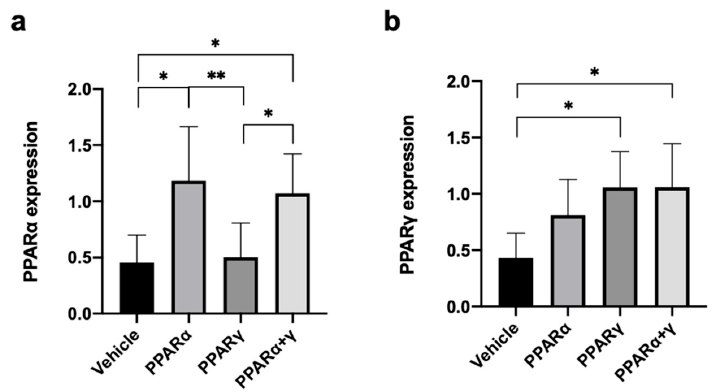
Figure 3. Expression of PPAR α and PPAR γ mRNA. At 6 h, real-time RT-PCR showed upregulation of mRNA expression levels of PPAR α in the alkali-burned cornea after PPAR α and PPAR α + γ treatment compared with the vehicle and the PPAR γ group ( a ). In addition, mRNA expression levels of PPAR γ were increased in the PPAR γ and PPAR α + γ groups in comparison to the vehicle group ( b ). Data are presented as the mean ± standard error ( n = 8 samples/group). ** p < 0.01, * p < 0.05.